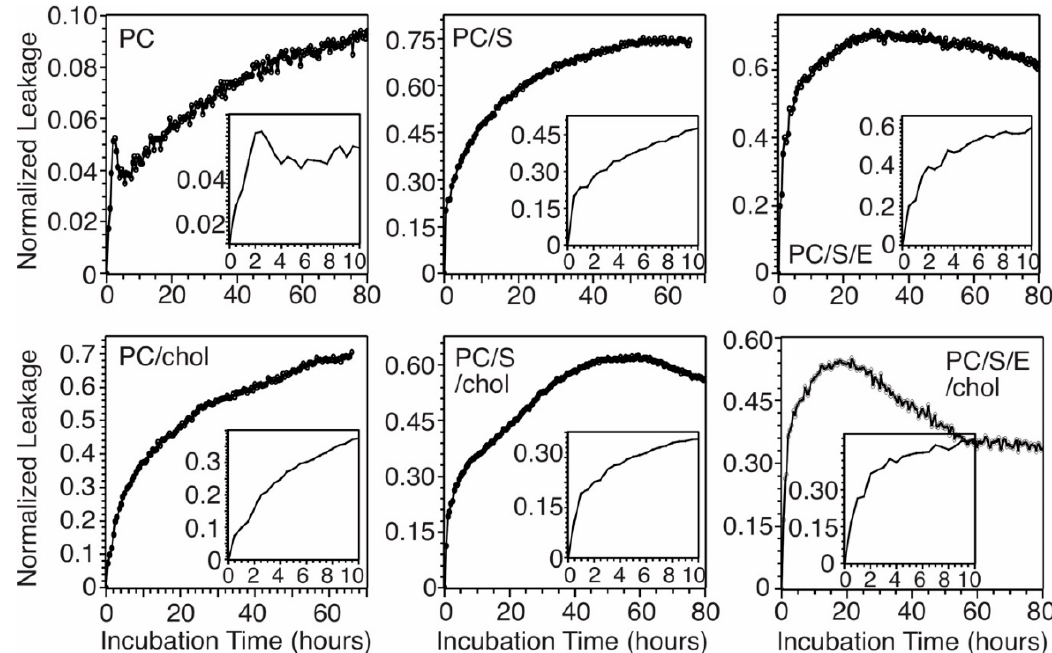
Figure 7. Calcein leakage assay for measuring the membrane content leakage with A β 40 fibrillization in different membrane models. Insets show the rapid increase of calcein leakages within the first 10 h of incubation.